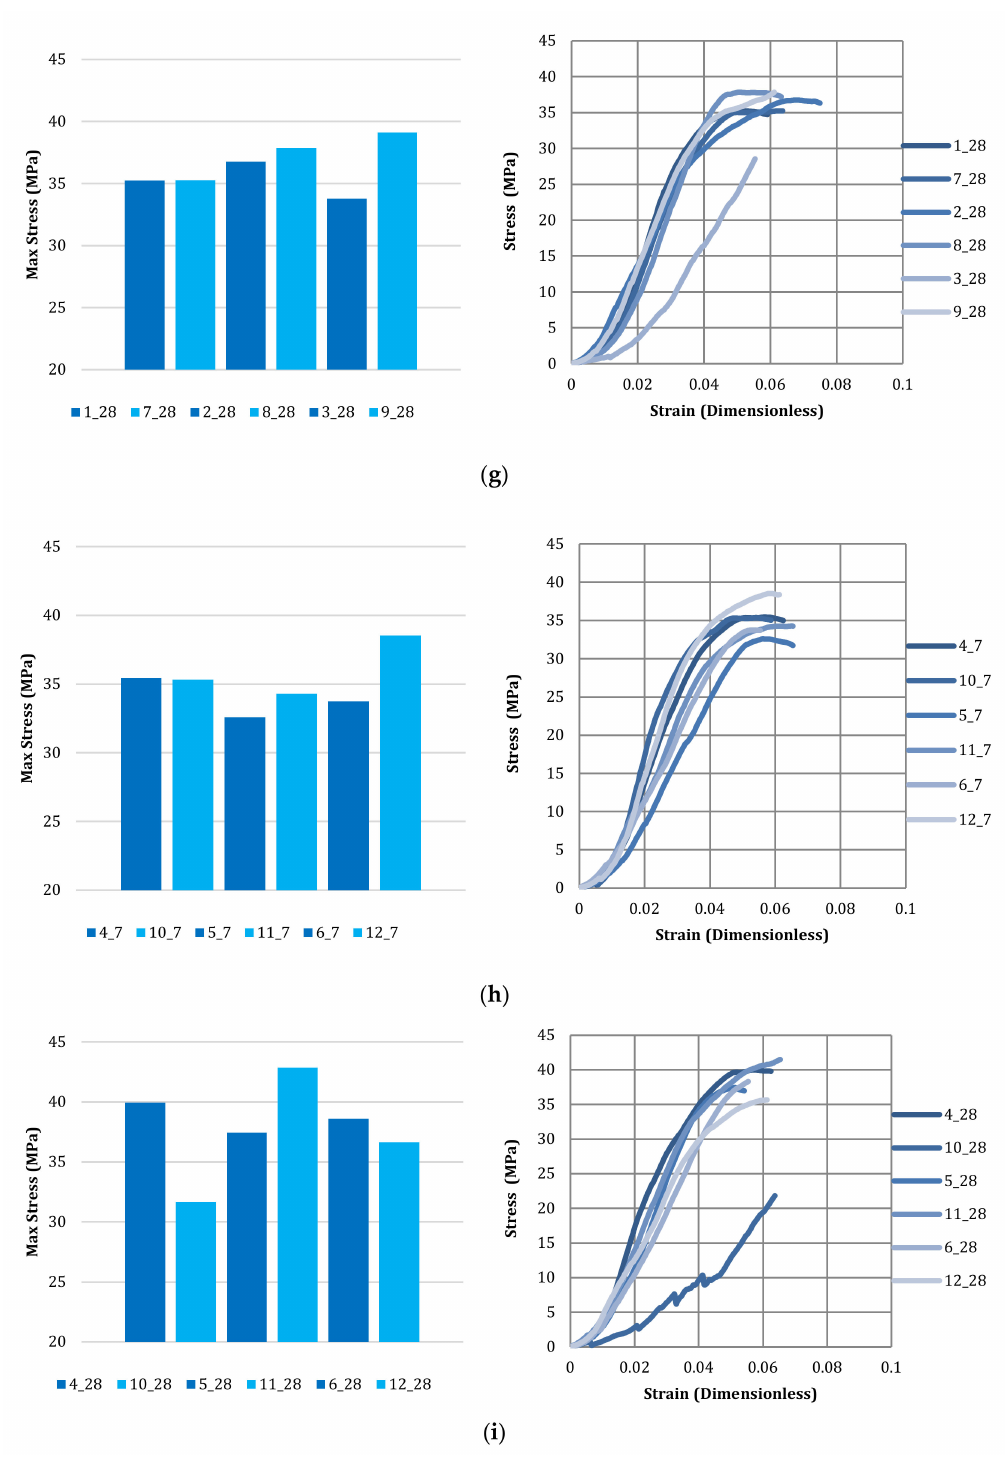
Figure 8. ( a ) Comparing the compressive strength and stress strain curves of the standard (controls 1 and 2) and unreacted kimberlite (controls 10 and 20) control bricks. ( b ) Comparing the compressive strength